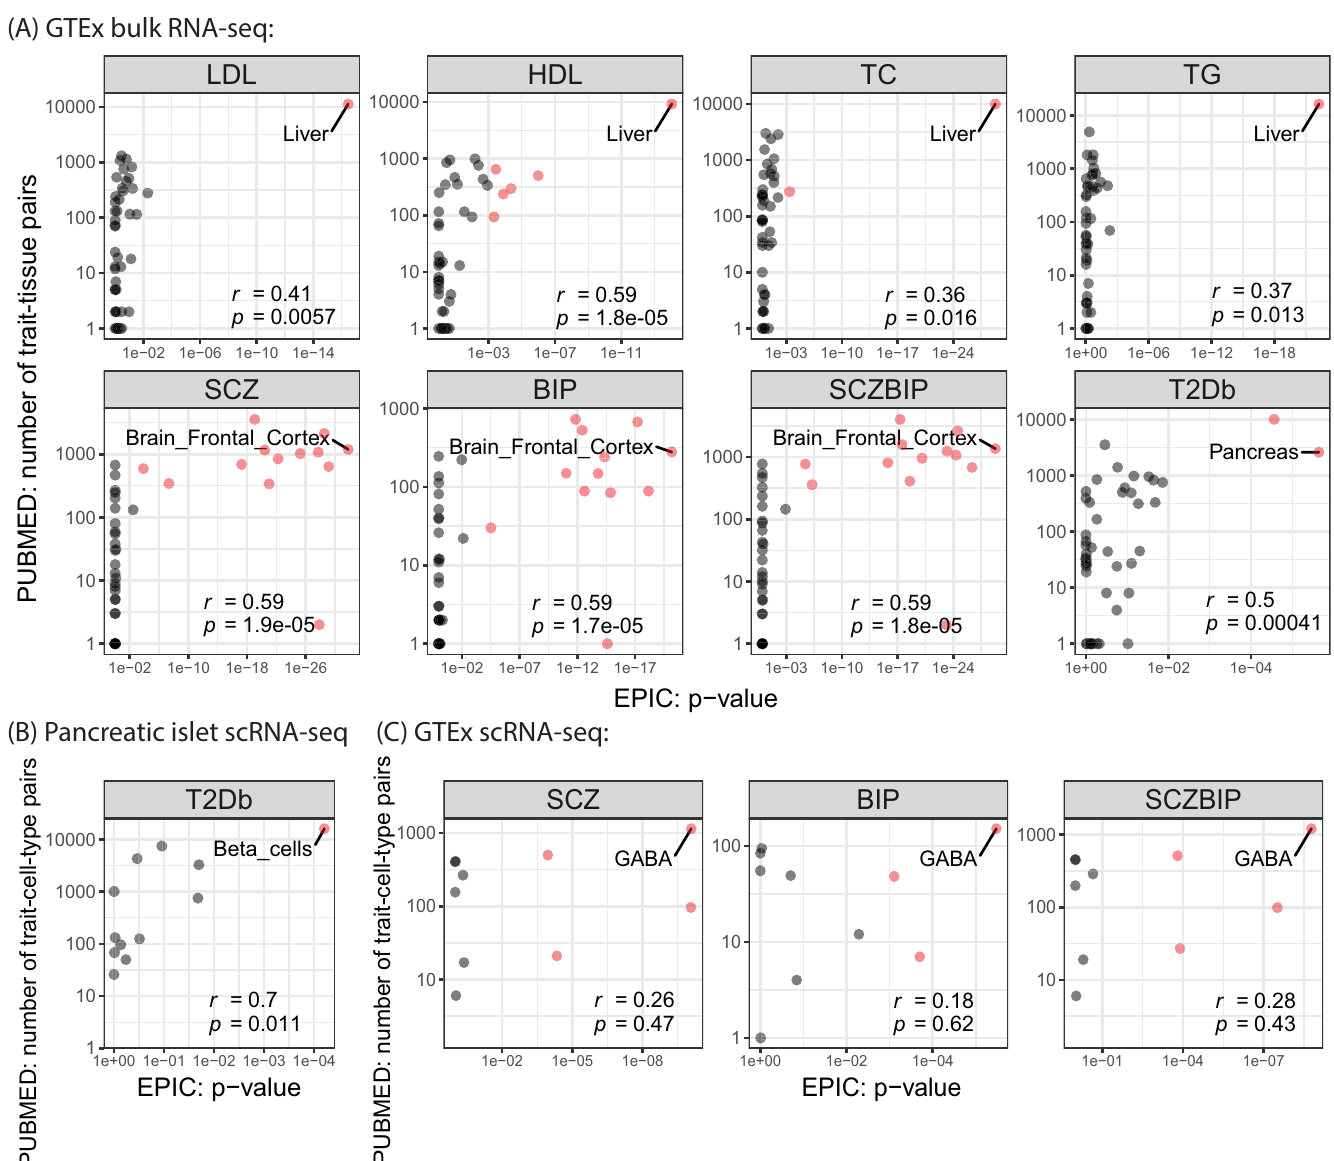
Fig 5. Correlations of tissue/cell type ranks from enrichment analysis and PubMed Search. Pearson correlations are calculated between the PubMed search and EPIC’s tissue- or cell-type-specific enrichment testing. Trait-relevant tissues/cell types with statistical significance after Bonferroni correction are highlighted in red, where the top-ranking tissues/cell types are labeled. Correlation coefficients and p -values from correlation test are included.